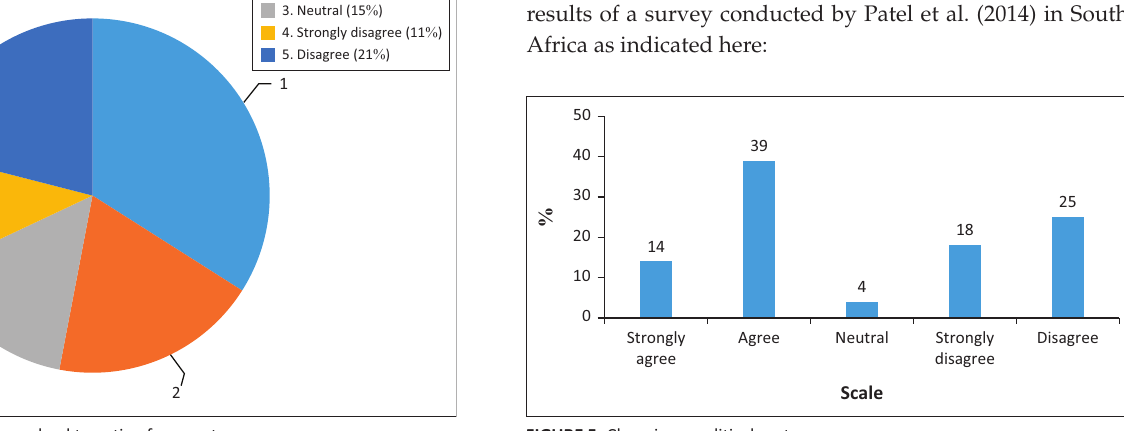
FIGURE 5: Changing a political party. FIGURE 4: Promises can lead to voting for a